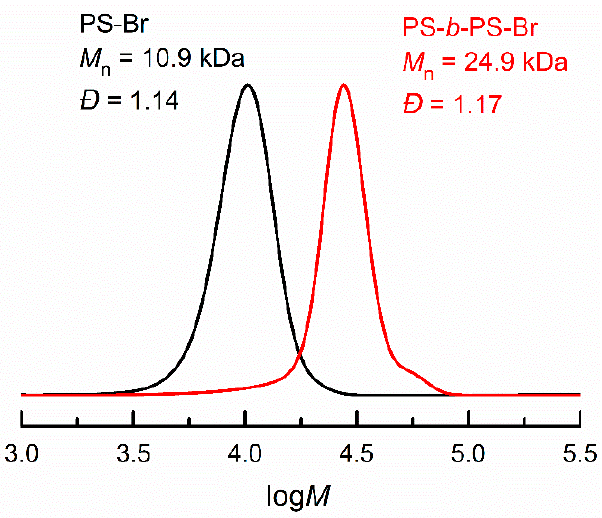
Figure 2. Cyclic voltammetry of 10 − 3 M [BrCu II TPMA] + in DMF/styrene (50:50, v/v) + 0.1 M Et 4 NBF 4